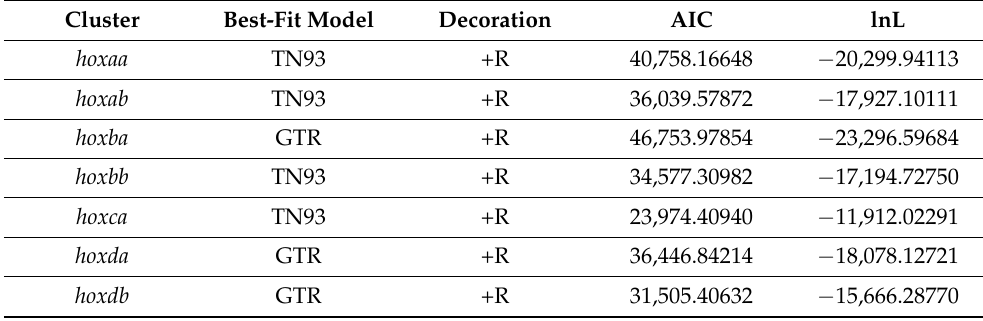
Table 2. Selection parameters of the best-fit phylogenetic model of each hox gene cluster.